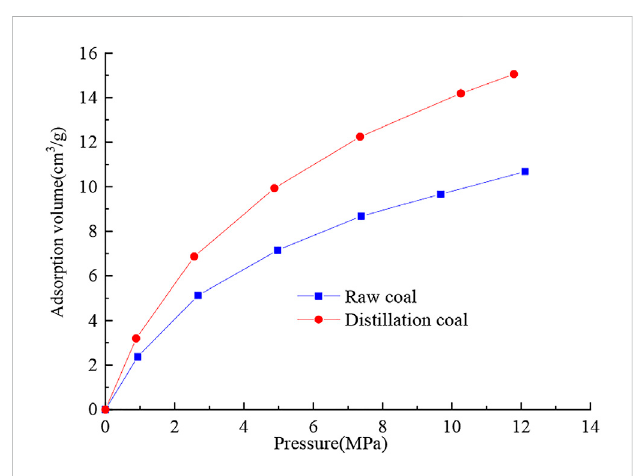
FIGURE 7 Methane adsorption isotherm of the raw and distillation